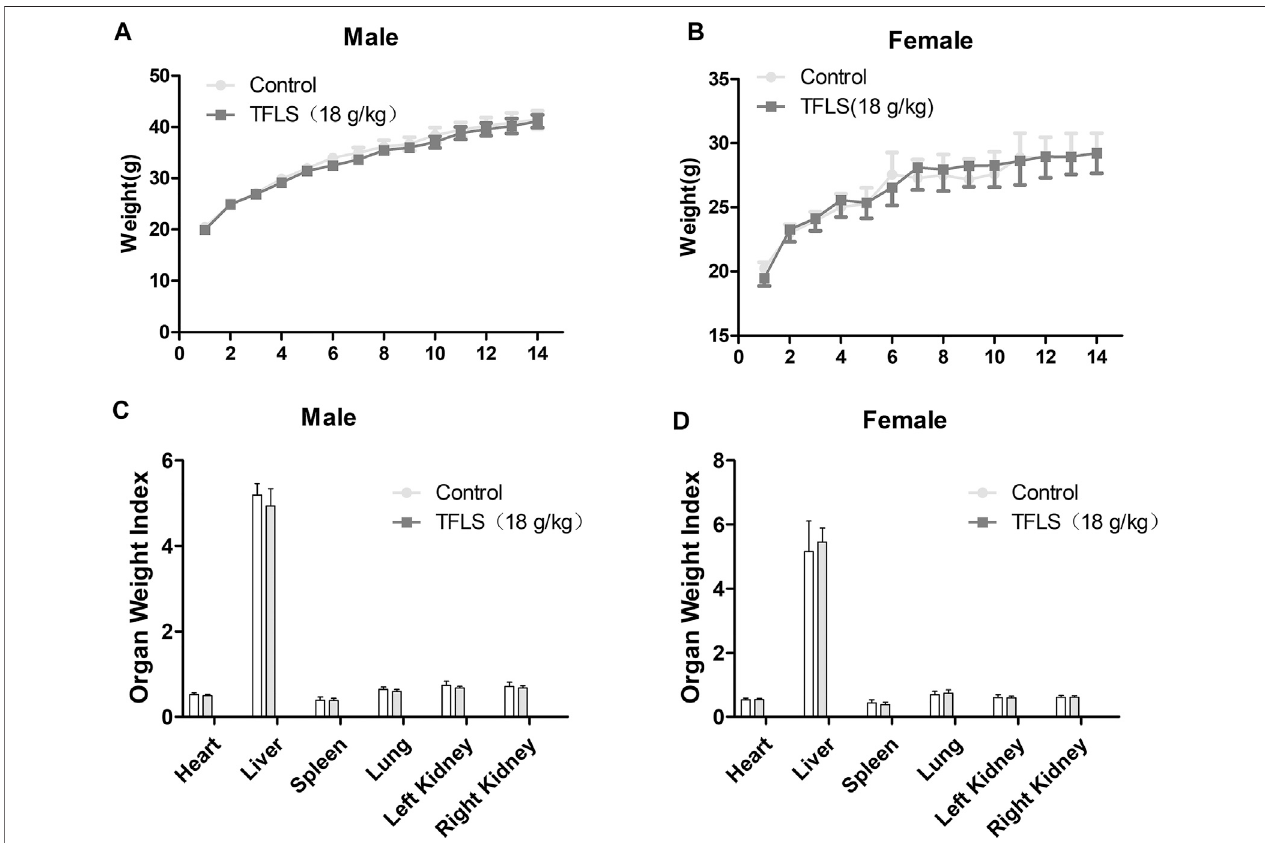
FIGURE10| TheeffectsofTFLSonbodyweightandOWI.TFLS(18 g/kgbodyweight)wasorallyadministeredthreetimesonthe fi rstday,withintervalsof6 h.The body weight was measured every day for 14 days in the male (A) and female (B) mice. On day 14, all animals were sacri fi ced. The vital organs were weighed and OWI was calculated (C,D) . Data are expressed as mean ±